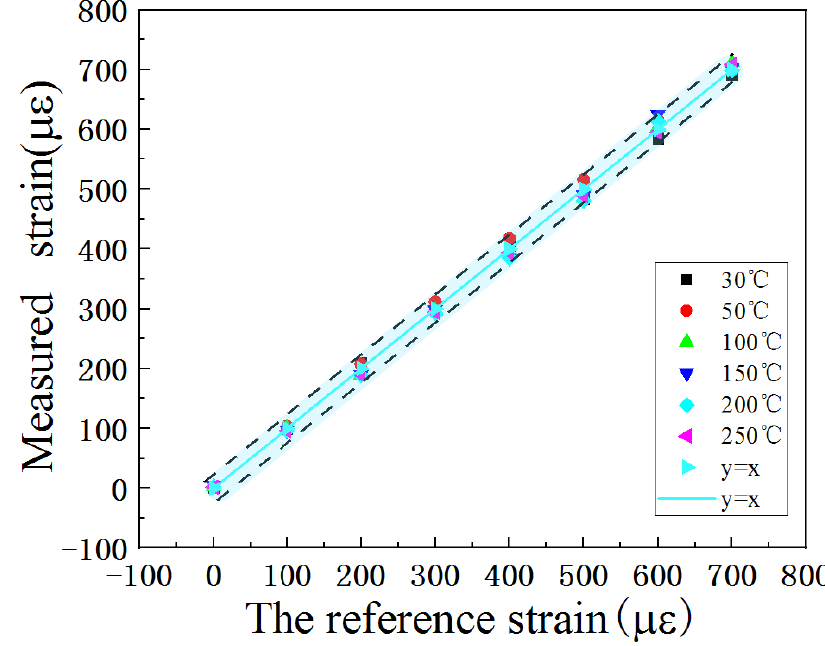
Figure 8. Error analysis of fitting results and test data.